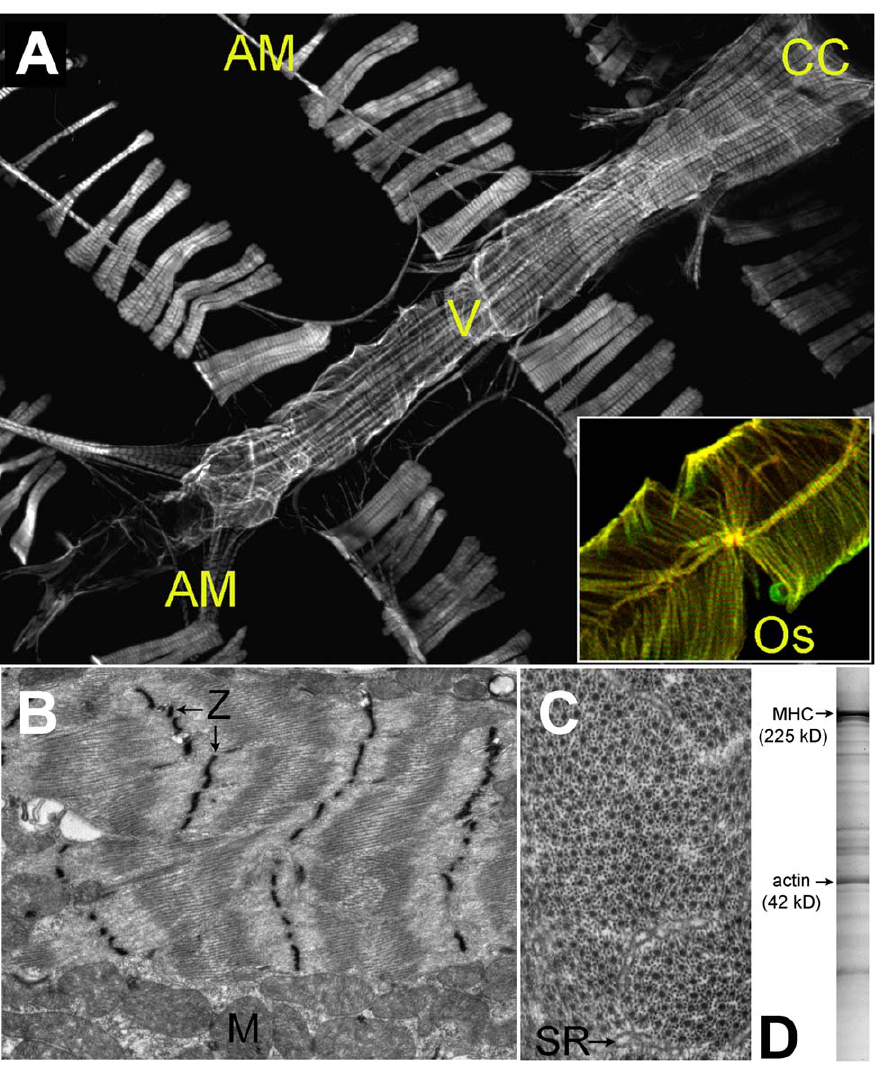
Figure 1. The Cardiac Tube ofDrosophilamelanogaster . Panel A. TRITC-Phalloidin labeled wild-type Drosophila heart tube and associated structures (10 6 magnification). CC=conical chamber; AM=alary muscle; v=internal valve; Os=ostia in flow tract. Inset: luminal surface of TRITC- Phalloidin-labeled myosin-GFP-expressing heart (20 6 magnification). Ostia inflow tracts and the striated alternating myosin and actin myofilament bands are clearly resolved. Panel B. Electron micrograph of a longitudinal section through the conical chamber reveals the contractile myofibrils and mitochondria (M)(3,800 6 ). Densely stained Z-bands (Z) demarcate individual sarcomeres and bisect the I-bands. Centrally-located A-bands are also apparent. Panel C. Cross-section through cardiac myofibrils of the conical chamber (10,500 6 ). Individual thick filaments are surrounded by 9–11